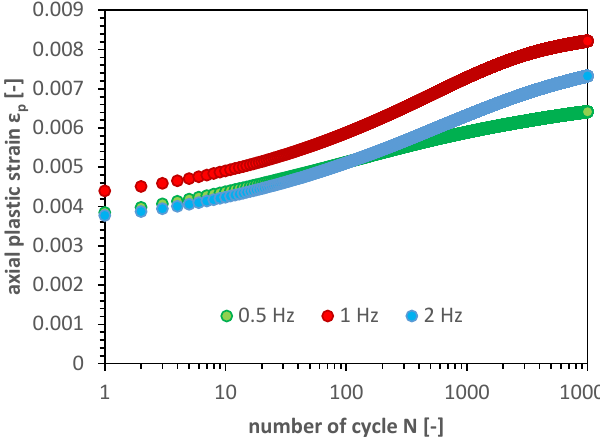
Figure 6. The accumulation of plastic strain characteristics in number of cycles.